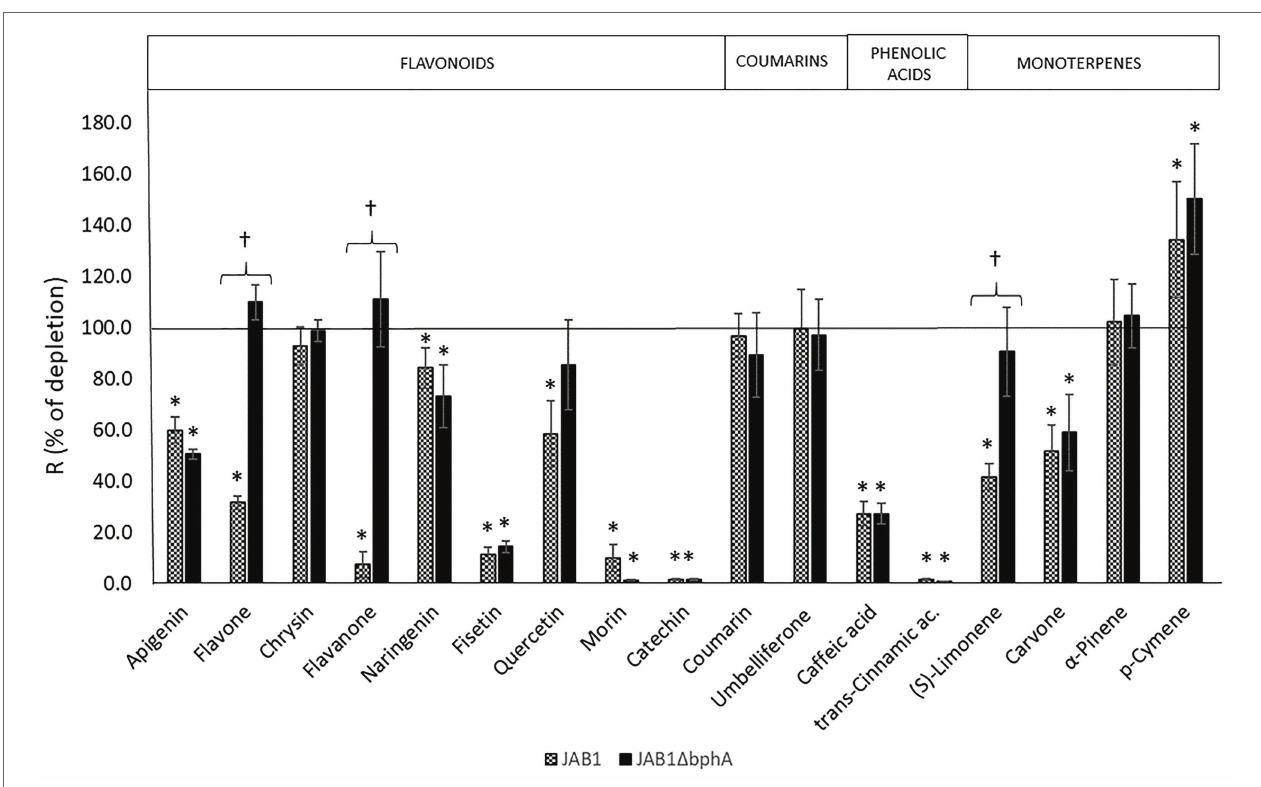
FIGURE 3 | Degradation of secondary plant metabolites (SPMs) by strains JAB1 and JAB1 Δ bphA. The ability of strains to degrade SPMs was tested by resting cell assay (RCA), depletion rates R in % of the corresponding abiotic controls are shown. Cells were incubated for 24 h in the presence of individual SPMs (0.25 mM). Error bars represent SD from three replicates. Asterisks ( ∗ ) show a depletion rate significantly different from the abiotic control, daggers ( † ) indicate a depletion by the wild-type JAB1 that is significantly different from the strain JAB1 Δ bphA. One-way ANOVA ( p < 0.05) was used to analyze the